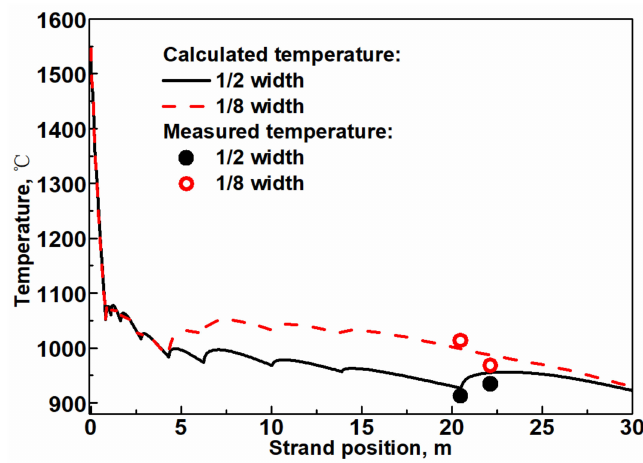
Figure 7. Comparison between the calculated and the measured